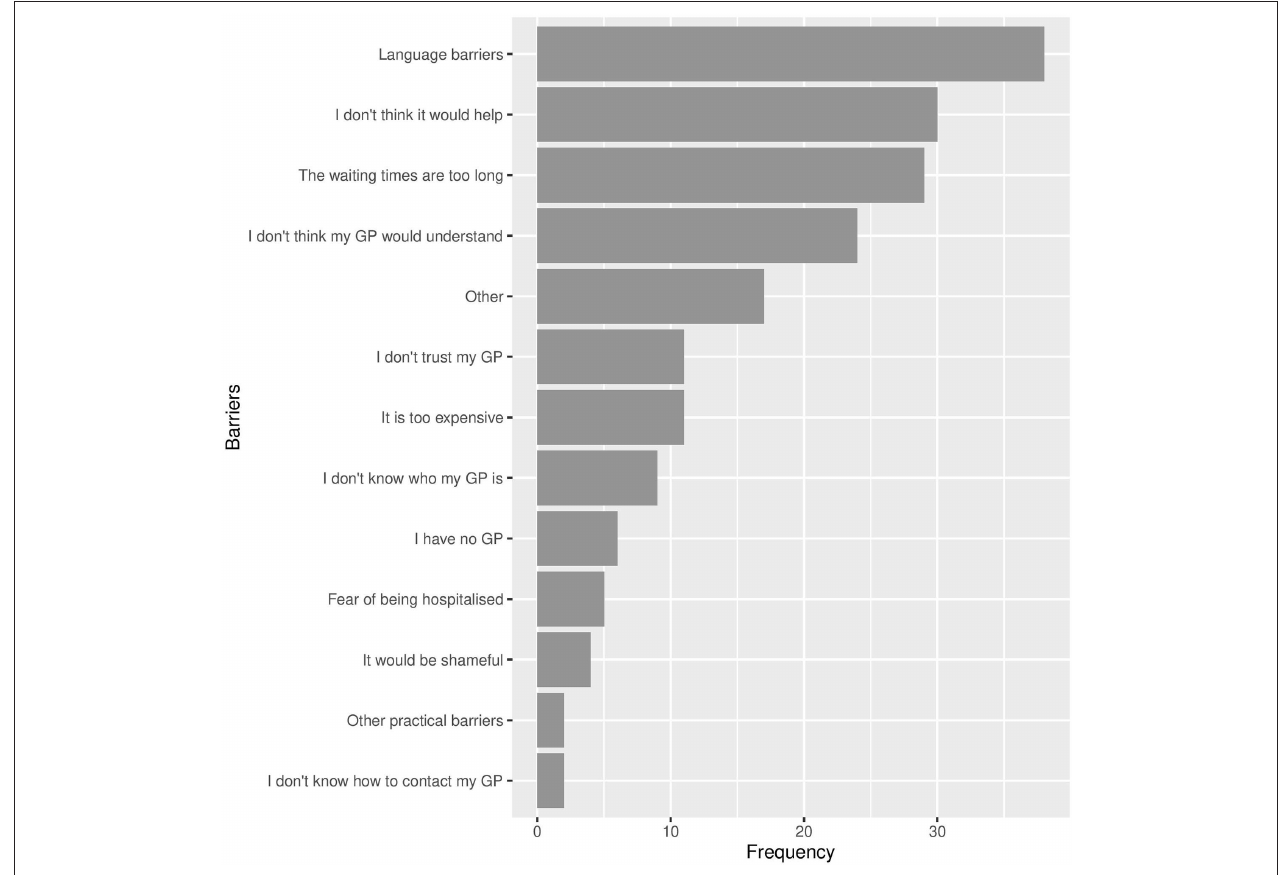
FIGURE 3 | Barriers reported by participants to seeking help from the GP ( N = 87). Note that participants could select several or no